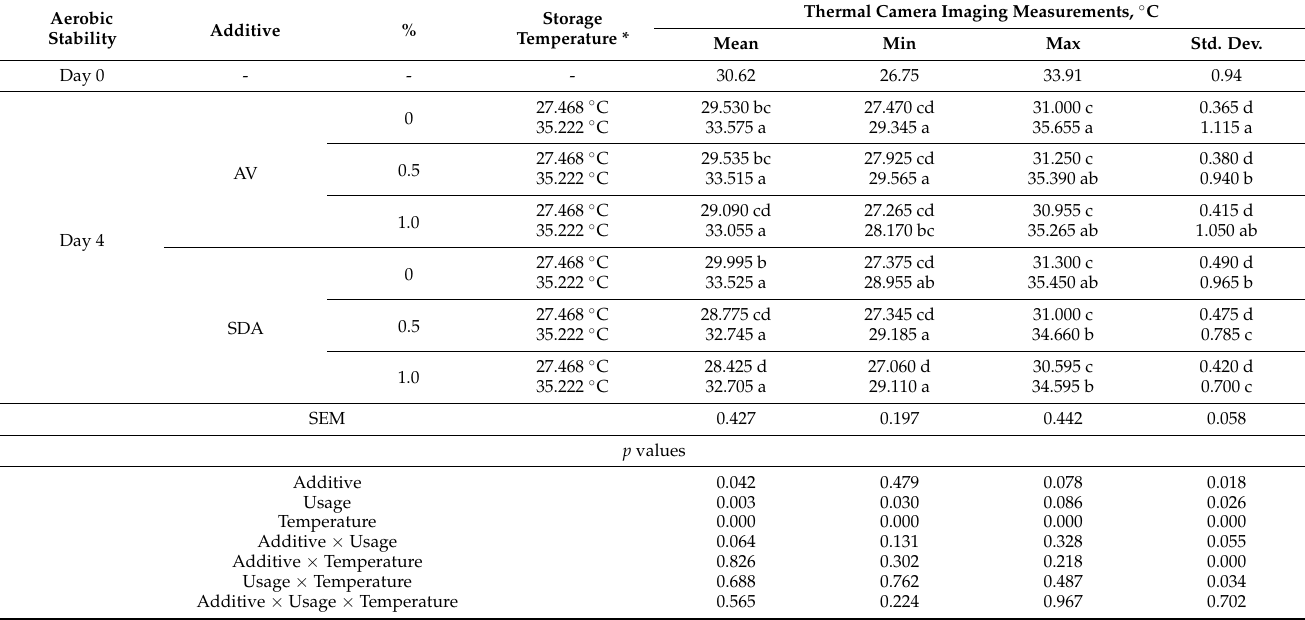
Table 7. Thermal camera imaging results of aerobic stability on day 4 (Ambient temperature = 22 ◦